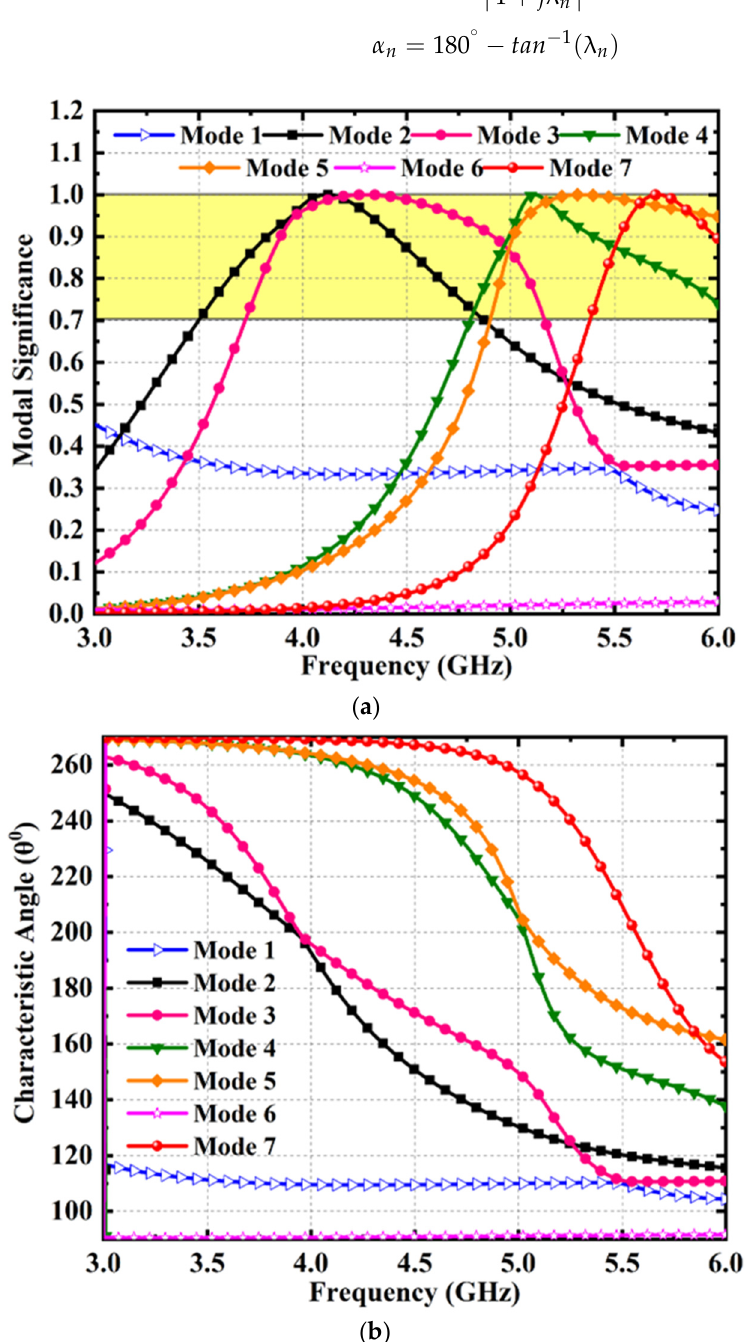
Figure 5. Two–element MIMO antenna TCM analysis; ( a ) modal significance; and ( b ) characteristic angle.